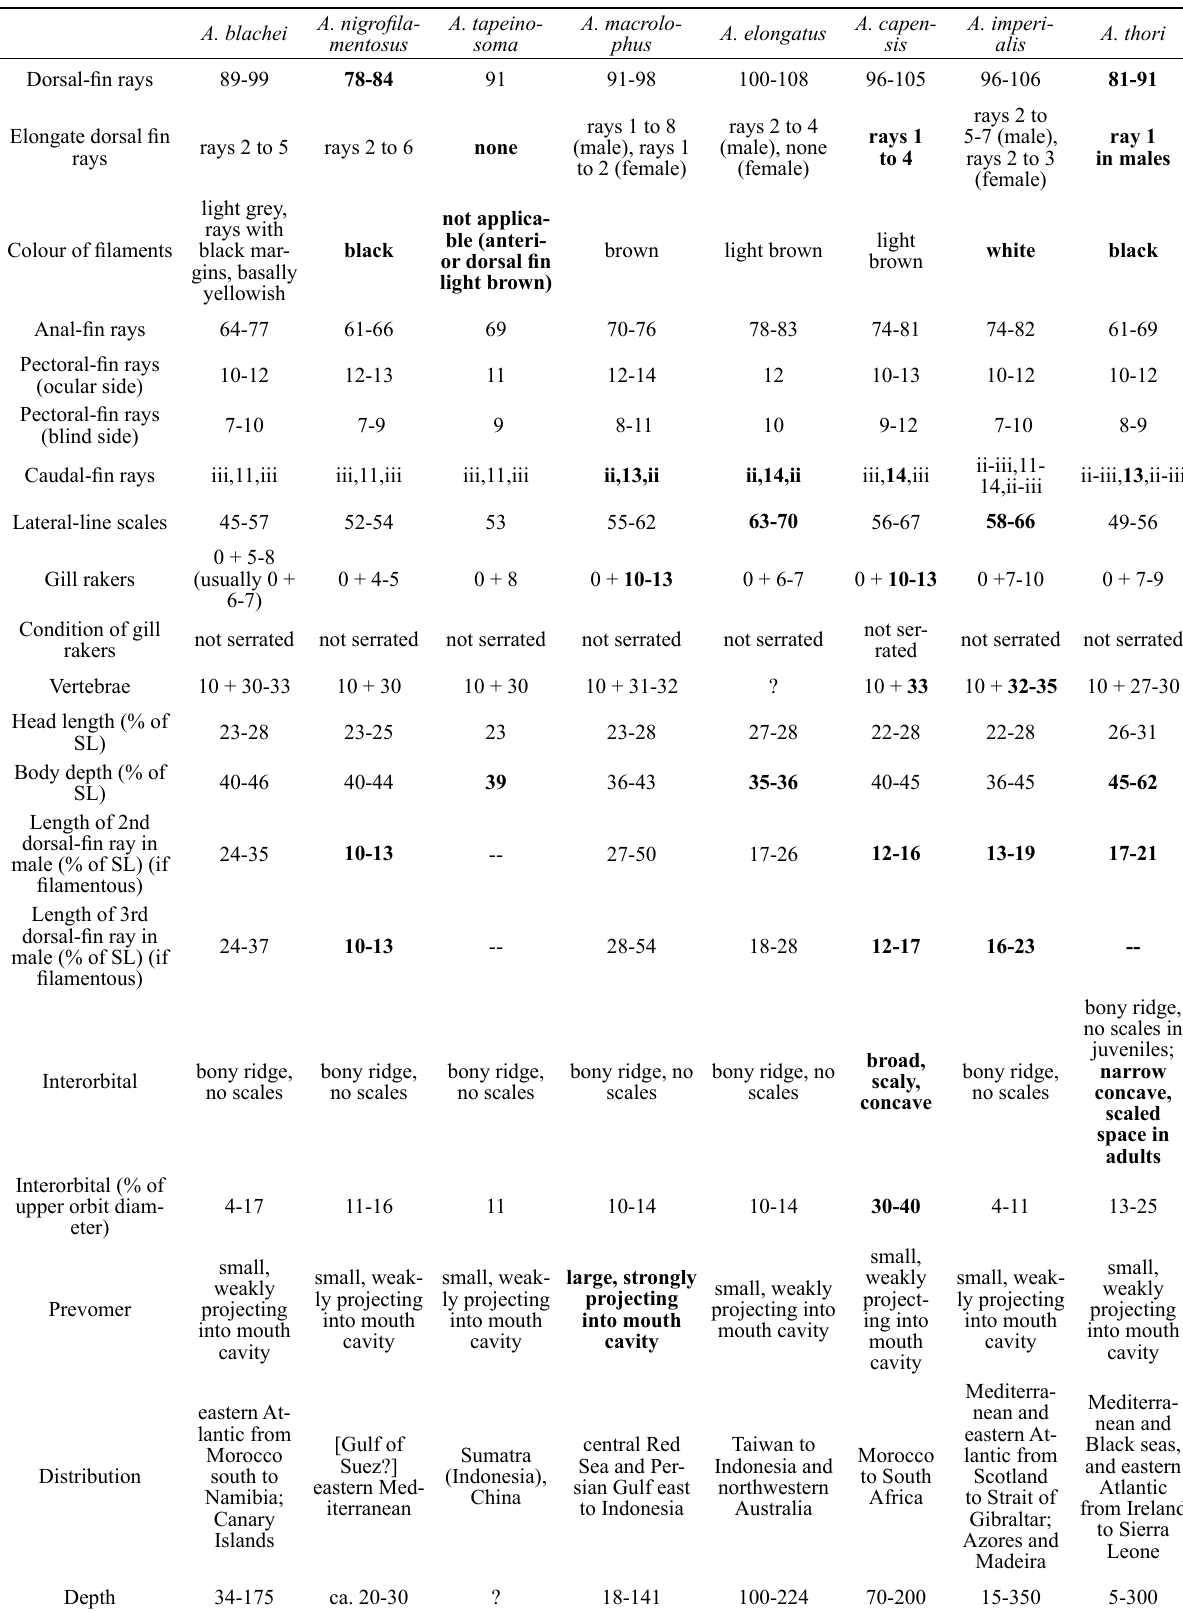
Table 6. – Comparison of the species of Arnoglossus with several elongate, filamentous rays anteriorly in the dorsal fin, and the closely related species A. tapeinosoma (some values taken from Arai and Amaoka 1996, Hensley and Amaoka 2001, Munroe 2016, Fricke et al. 2017). Values differing from A. blachei are printed in bold face